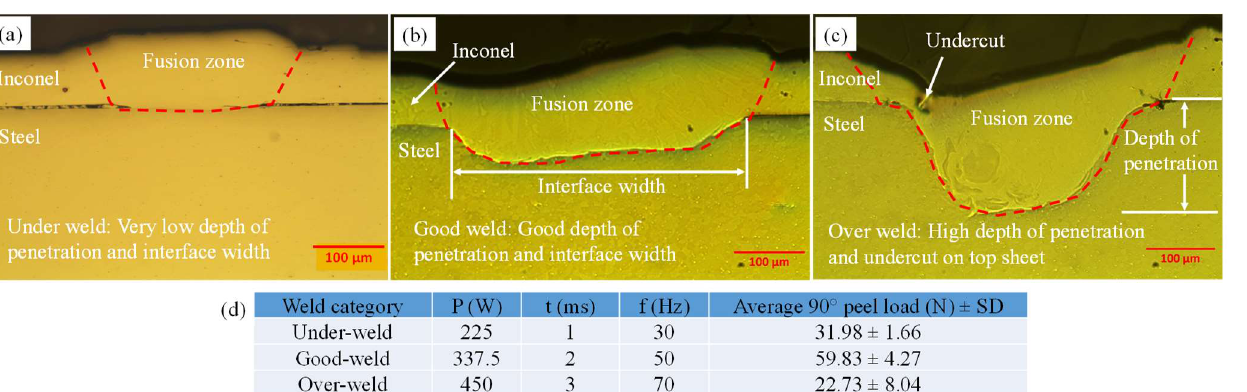
Figure 7. Optical micrographs of laser-welded joints in ( a ) under-weld, ( b ) good-weld and ( c ) over- weld conditions with ( d ) the parameters used for the welding.